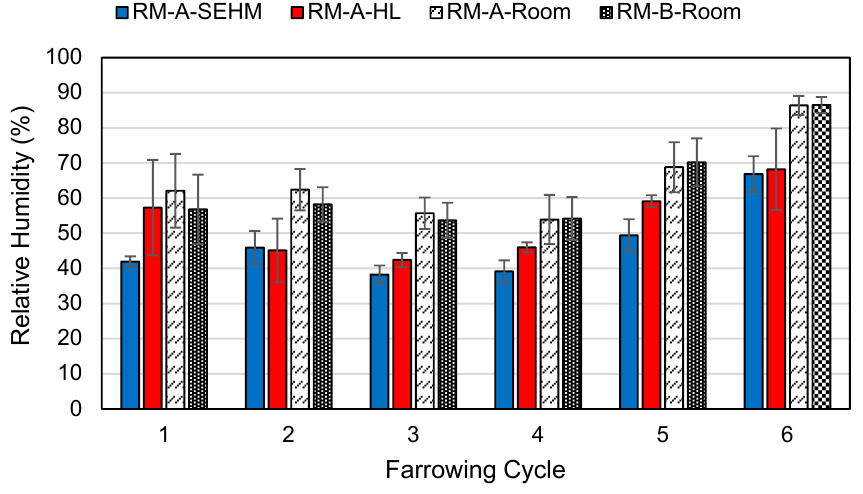
Figure 7. Mean radiant temperature of the creep area microclimate by heat source and farrowing cycle. Error bars represent one standard deviation of the mean.